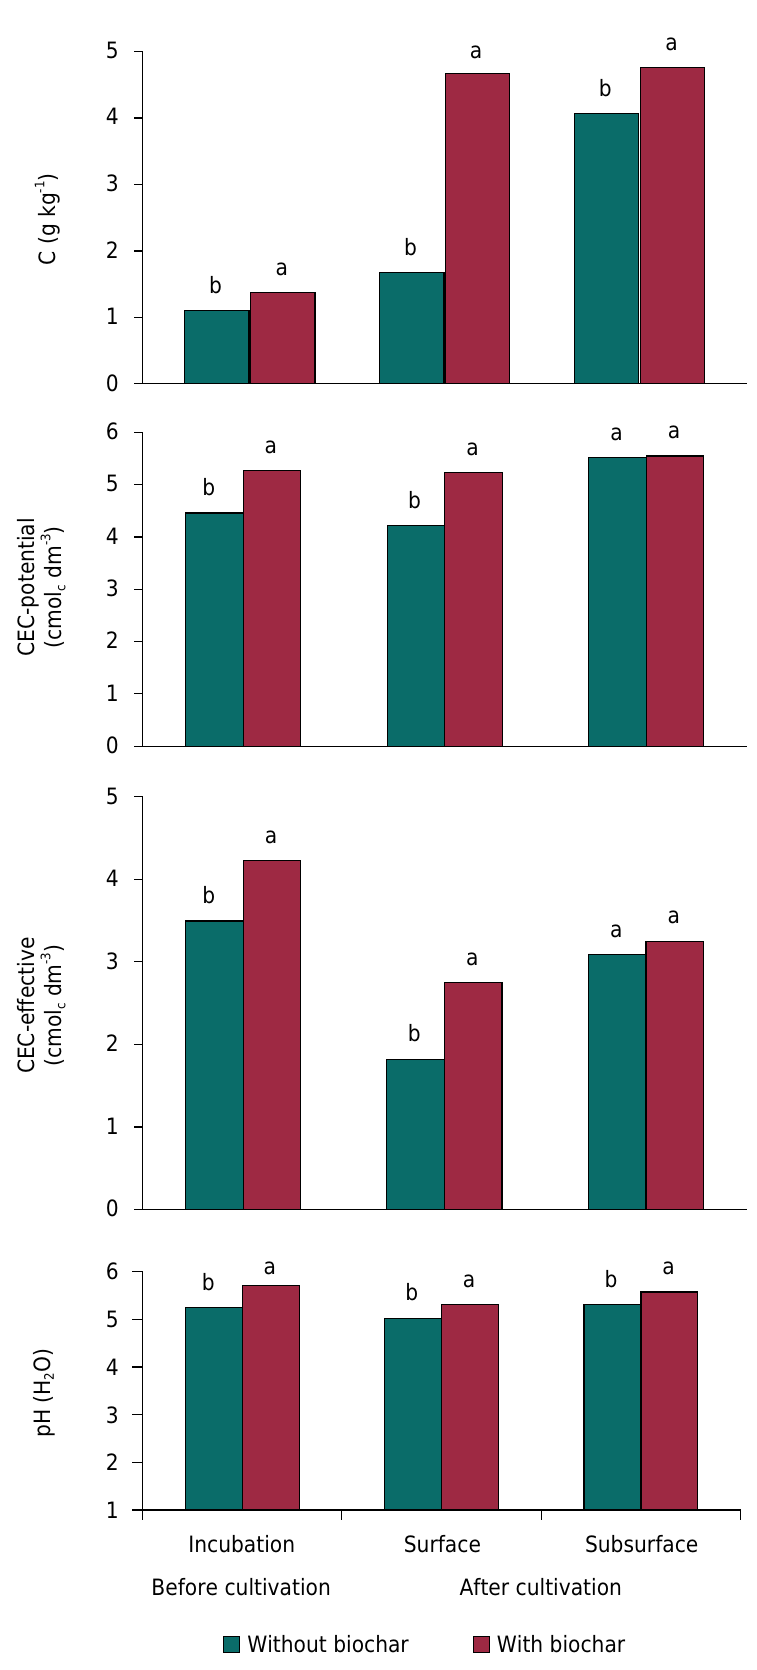
Figure 4. Mean values of soil carbon content (a); potential CEC (b), effective CEC (d), and pH (e) in the newly incubated soil and the surface and subsurface soils (after the mucuna cultivation) treated with or without biochar. Different lowercase letters indicate a significant difference by the Tukey test at 5 % (average of 6 replicates). CEC: cation exchange